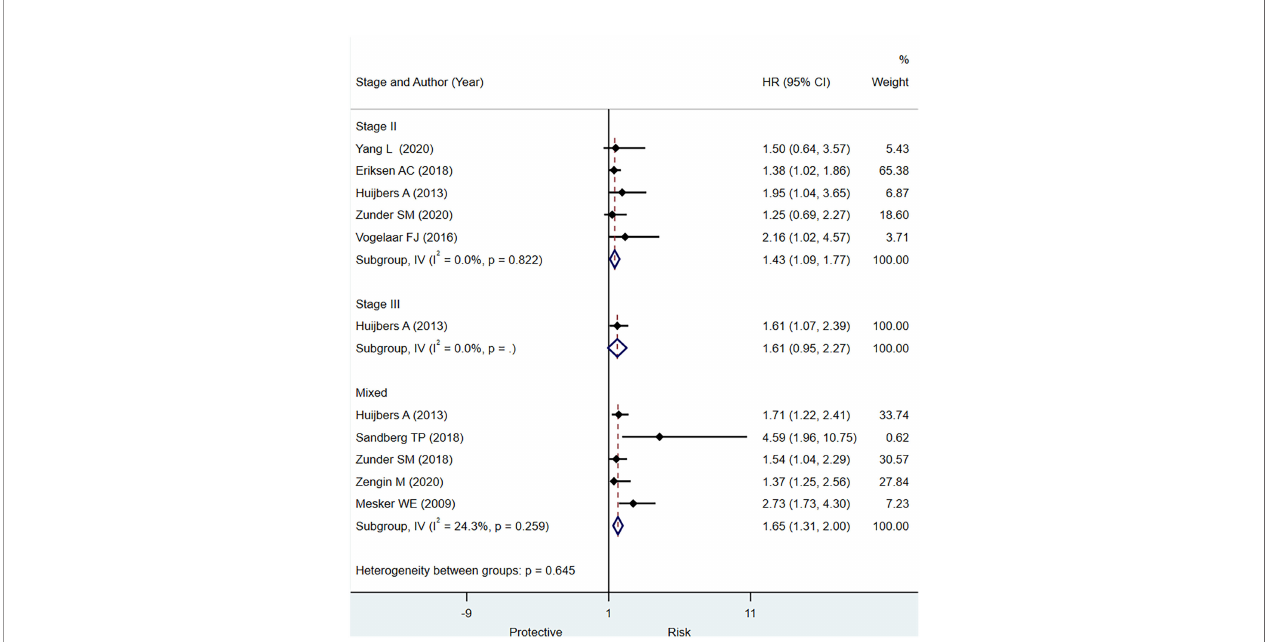
signi fi cance of low TSR for predicting DFS and OS in patients with CRC.